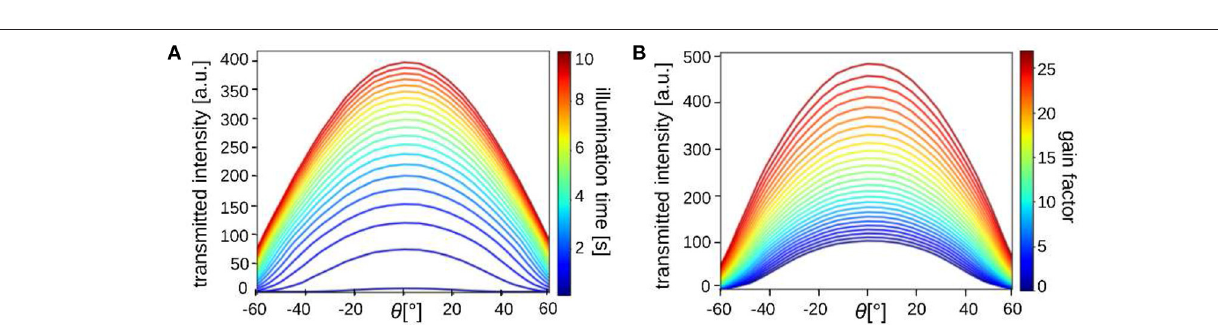
FIGURE 4 | The average transmitted light intensity of a diffusor plate (inner 1000 × 1000 px) illuminated by 8 × 8 LEDs from 32 different positions (along the center-line of the LED display; θ = 0 ◦ corresponds to the middle position of the display, cf. Figure 1A ). The different curves belong to measurements with (A) different illumination times (100, 500, 1,000, 1,500ms, ... , 10s) with gain 3, and (B) different gain factors (1, 2,..., 27) with 1 s